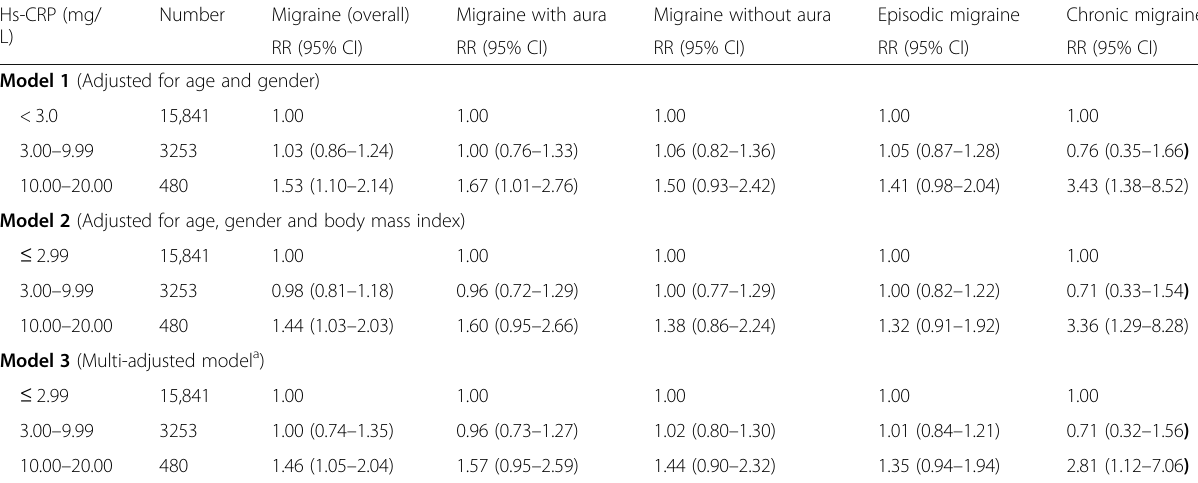
Table 2 Risk of migraine in HUNT4 based on categories of high sensitivity C-reactive protein (hs-CRP) in HUNT3 evaluated by poisson regression with 95% confidence